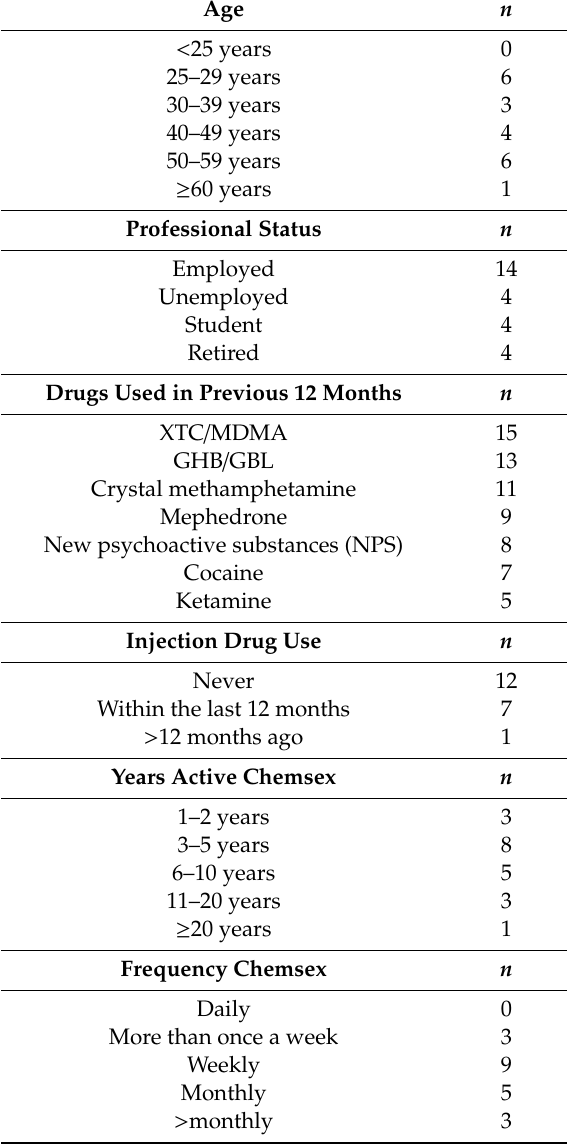
Table 1. Characteristics of gay, bisexual, and other men who have sex with men (GBMSM) who participated in the in-depth interviews ( n =